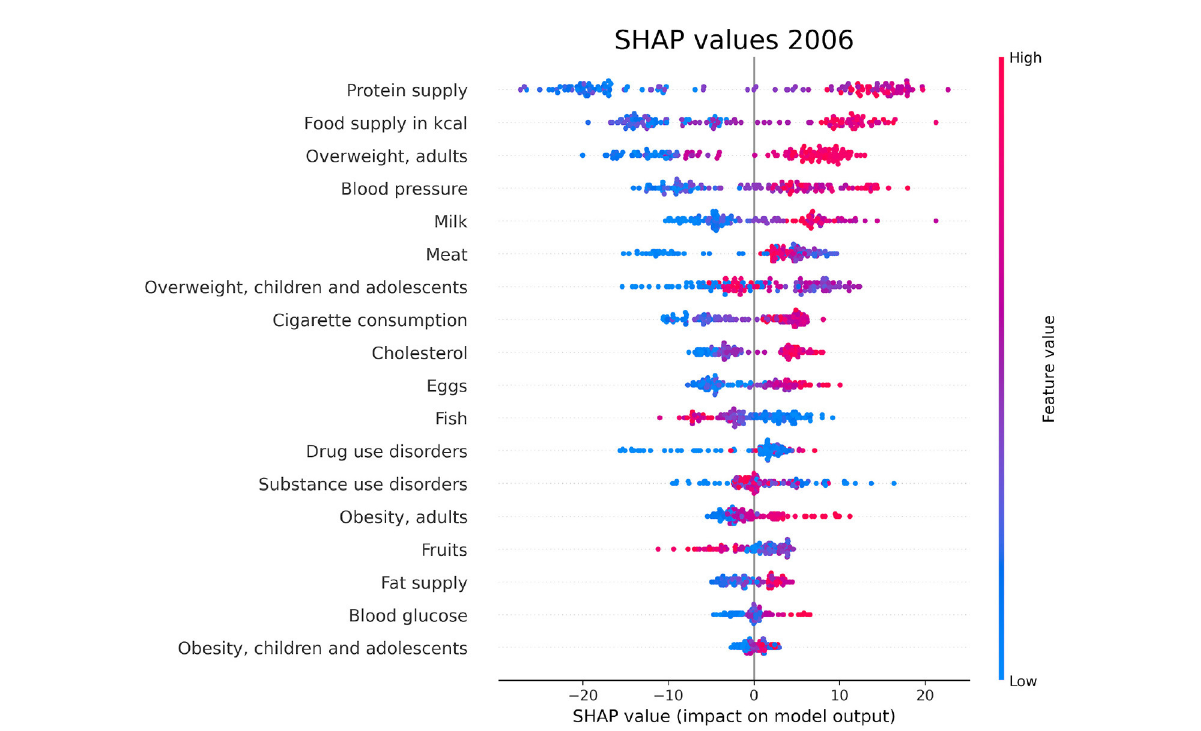
FIGURE7 SHAP values corresponding to the features that are most influential in the prediction of PAD for the year 2006. Different points in the same row are associated to the prediction made for different